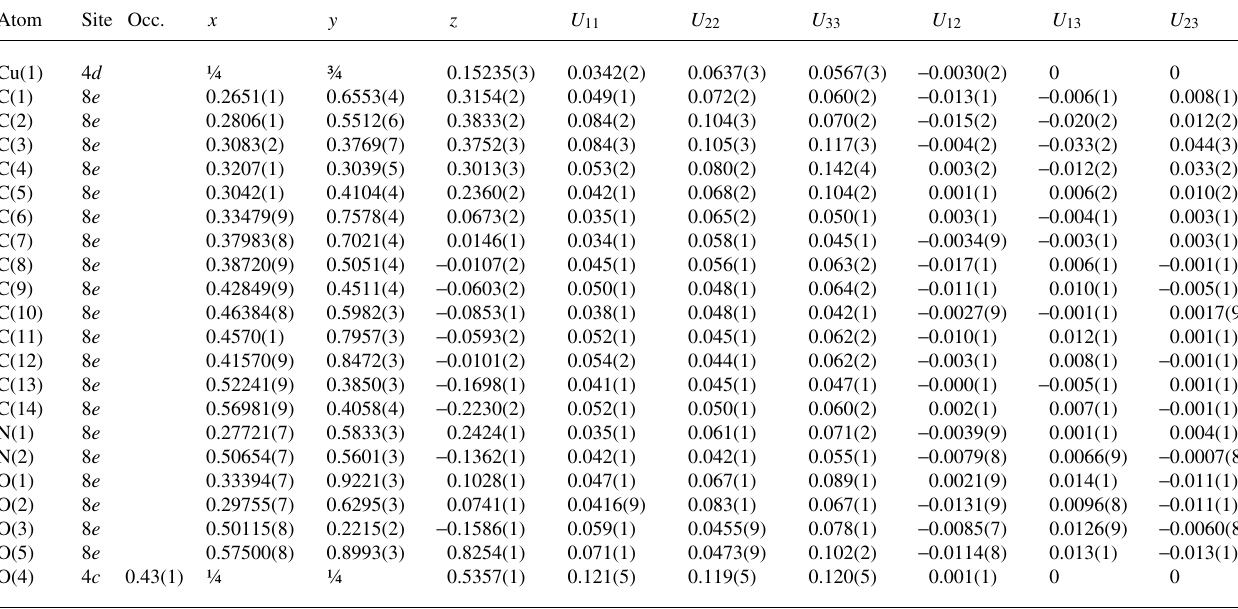
Table 3. Atomic coordinates and displacement parameters (in Å 2 ) .